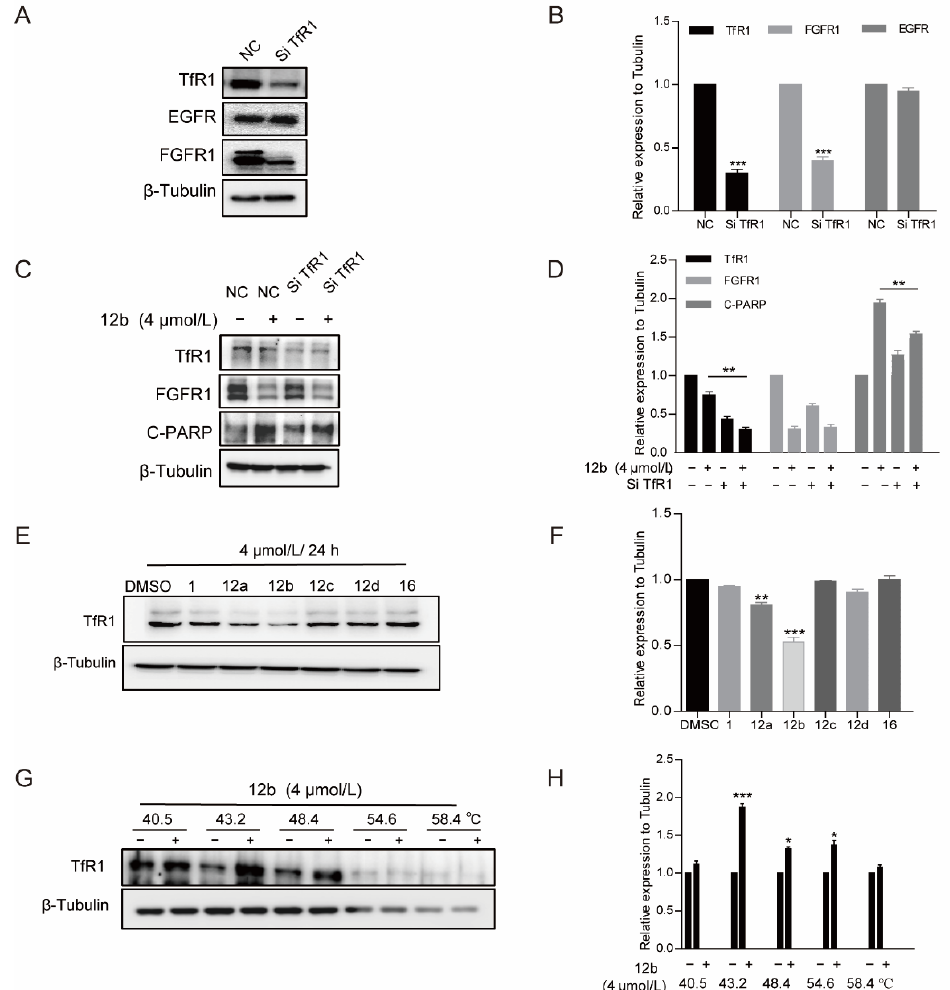
Figure 7. 12b -induced apoptosis of MDA-MB-231 cells depends on TfR1. ( A , B ) MDA-MB-231 cells were transfected with TfR1-targeting siRNA by using Lipo3000 transfection reagents. After 48 h, the transfection efficiency was examined by Western blotting. ( C , D ) Cells with/without TfR1-knock- down were treated with 12b (4 μM), protein levels were analyzed by Western blotting, and protein band densities were quantified by normalizing to β -Tubulin. ( E , F ) MDA-MB-231 cells were treated with 12a – 12d and 16 (4 μM) for 24 h, the level of TfR1 was detected b y Western blotting, The relative band intensities of proteins to the β -Tubulin were analyzed and densities were quantified by nor- malizing to DMSO group. ( G , H ) Effect of 12b on TfR1 stabilization. MDA-MB-231 cells were treated with or without 12b (4 μM) for 2 h before being heated at different temperatures. Protein levels were analyzed by Western blotting. The relative band intensity to β -Tubulin was analyzed. Protein band densities were quantified by normalizing to DMSO. Data are presented as means ± SD. All experi- ments were performed in three replicates. * p < 0.05, ** p < 0.01, *** p < 0.001 versus DMSO.